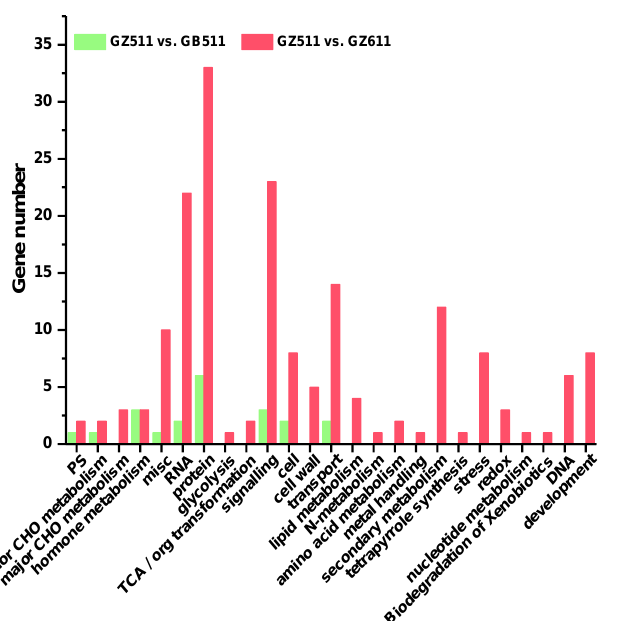
Figure 3. Functional category of DE − target genes of DE − miRNAs during Eu − rubber biosynthesis. In GZ511 vs. GZ611, we identified 65 DE − miRNAs and 239 corresponding DE − target genes (Figure 2B,C, Table S8), including 10 genes involved in the rubber biosynthesis pathway, such as acetyl − CoA C − acetyltransferase 1 ( EuAACT1 ) in the MVA pathway, EuDXS2 in the MEP pathway, and EuSRPP1, which is involved in rubber elongation [7]. We also conducted functional category analysis for the DE − target genes of DE − miRNAs. In total, 236 genes had A. thaliana homologs and were assigned to 25 MapMan categories (Table S9). The top five categories were protein (33 genes), signaling (23 genes), RNA (22 genes), transport (14 genes), and secondary metabolism (12 genes) (Figure 3, Table S9). In addition, these DE − target genes were significantly assigned to 107 GO terms related to S10). In the cellular component category, the top three terms were cell, cell part, and cyto-